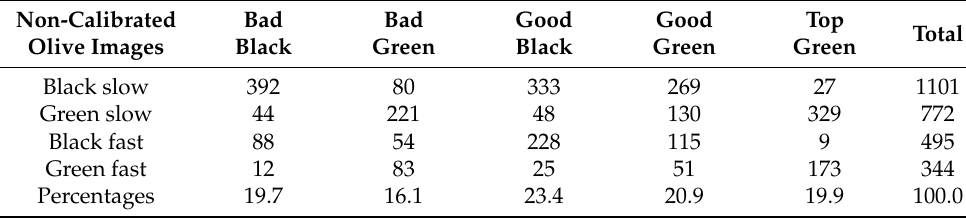
Table 6. Results of the external test of non-calibrated olive images. The rows report the sorting machine output, while the columns report the conveyor belt